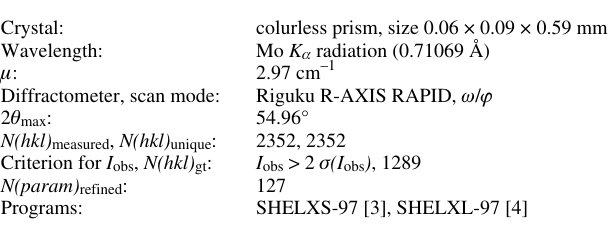
Table 1. Data collection and handling.